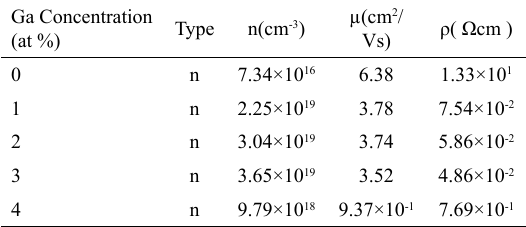
Table 2. Carrier type, concentration (n), mobility (µ) and resistivity (ρ) of the